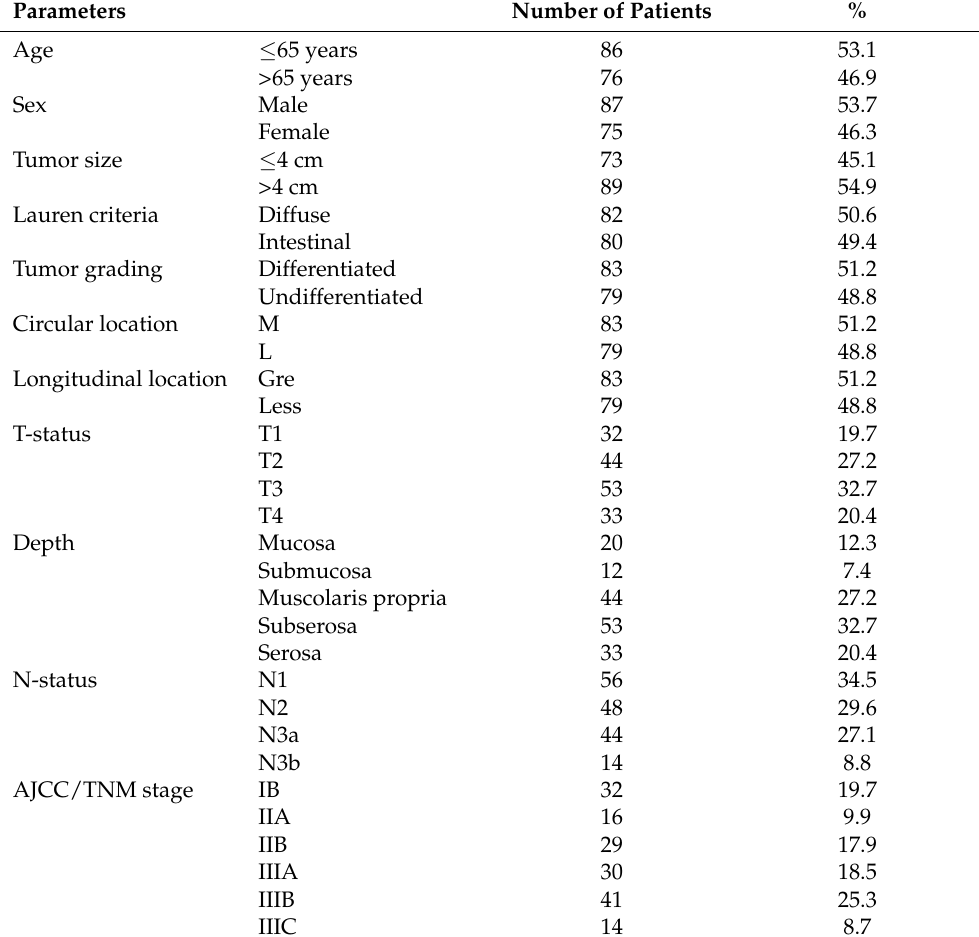
Table 1. Demographic and clinicopathological characteristics in 162 patients.